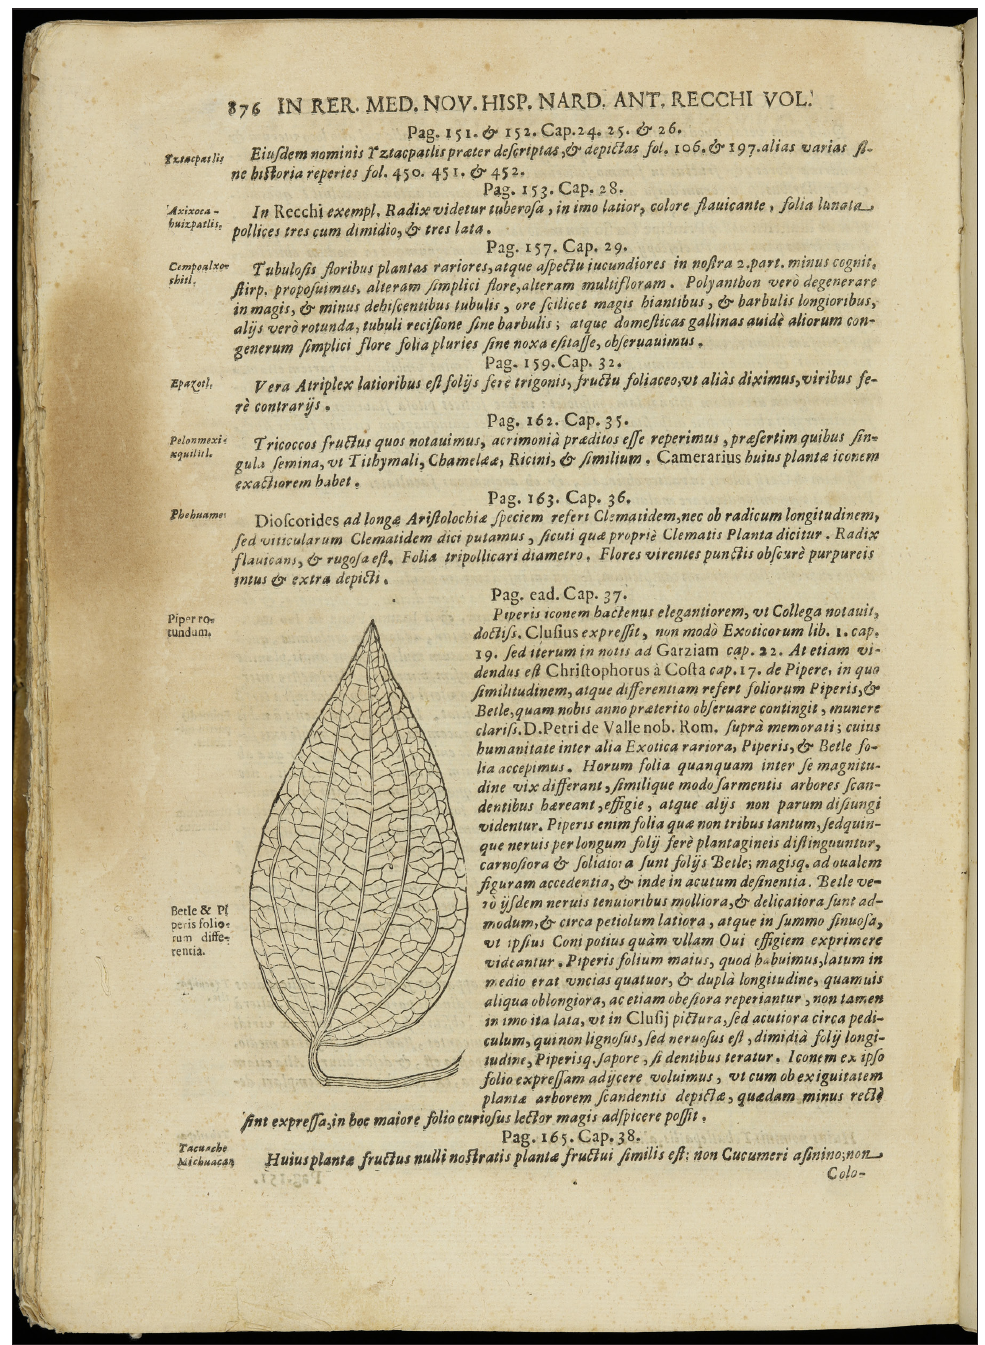
Figure 5: Description and woodcut of the Piper rotundum from Hernández et al., Rerum medicarum 1648– 1651, 876 (by permission of the Accademia Nazionale dei